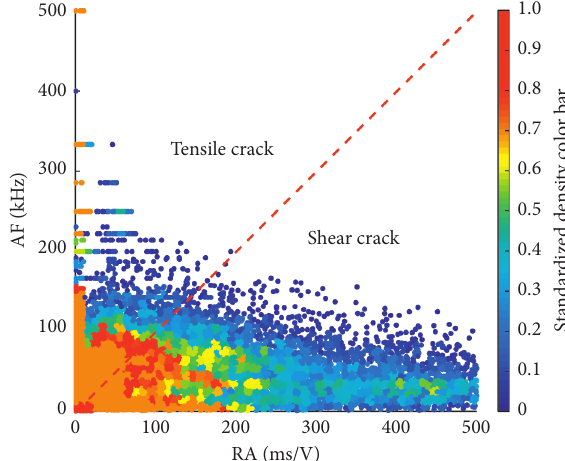
Figure 5: RA-AF scatter density distribution map of preset angle shear (specimen CS-2).